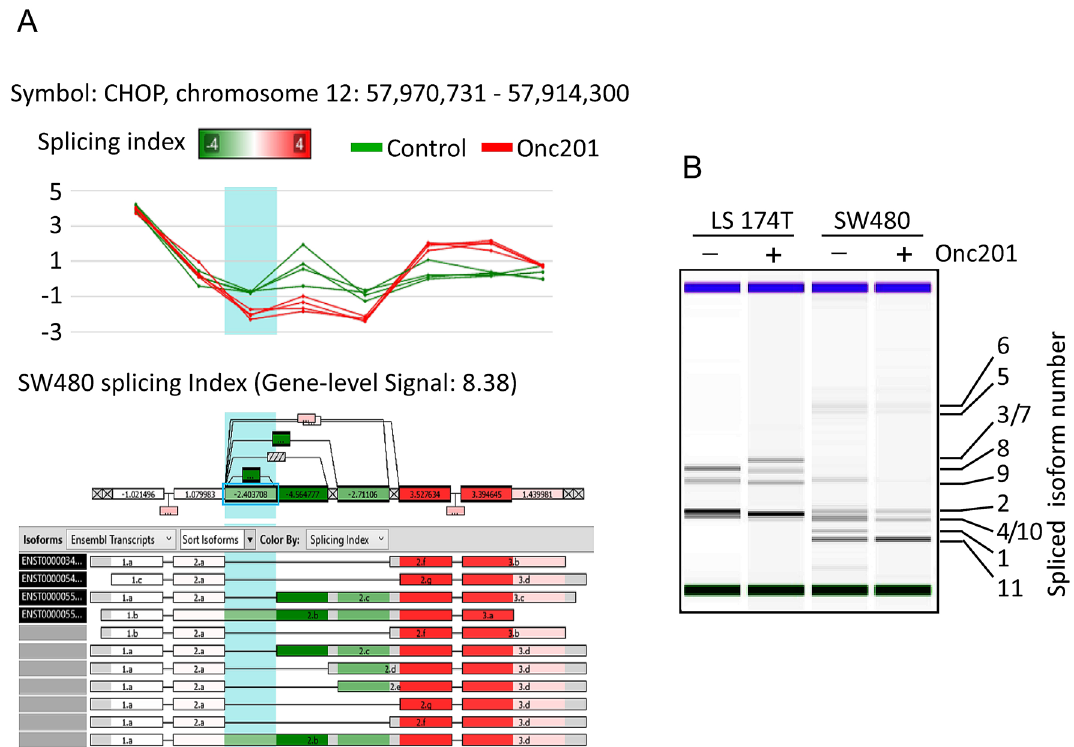
Figure 8. Alternative spliced variants of CHOP. ( A ) A computational analysis detecting CHOP differential alternative splicing events obtained from the microarray study of SW480 treated with and without ONC201. ( B ) Bioanalyzer electrophoresis after quantitative PCR analysis of LS-174T and SW480 cells treated with and without ONC201. CHOP was amplified using specific primers flanking the exons 1 and 4. PCR products were fractionated on Bioanalyzer microgel. Alternative spliced isoforms were mapped according to their fragment